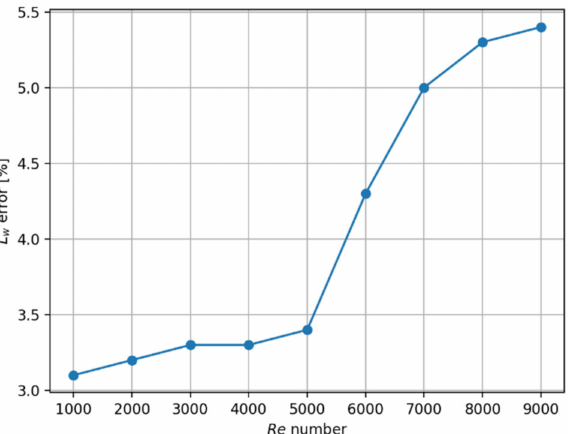
Figure 9. Error for the optimized turbulence model over the testing set measured as in L w in Equation (17) as a function of the Reynolds